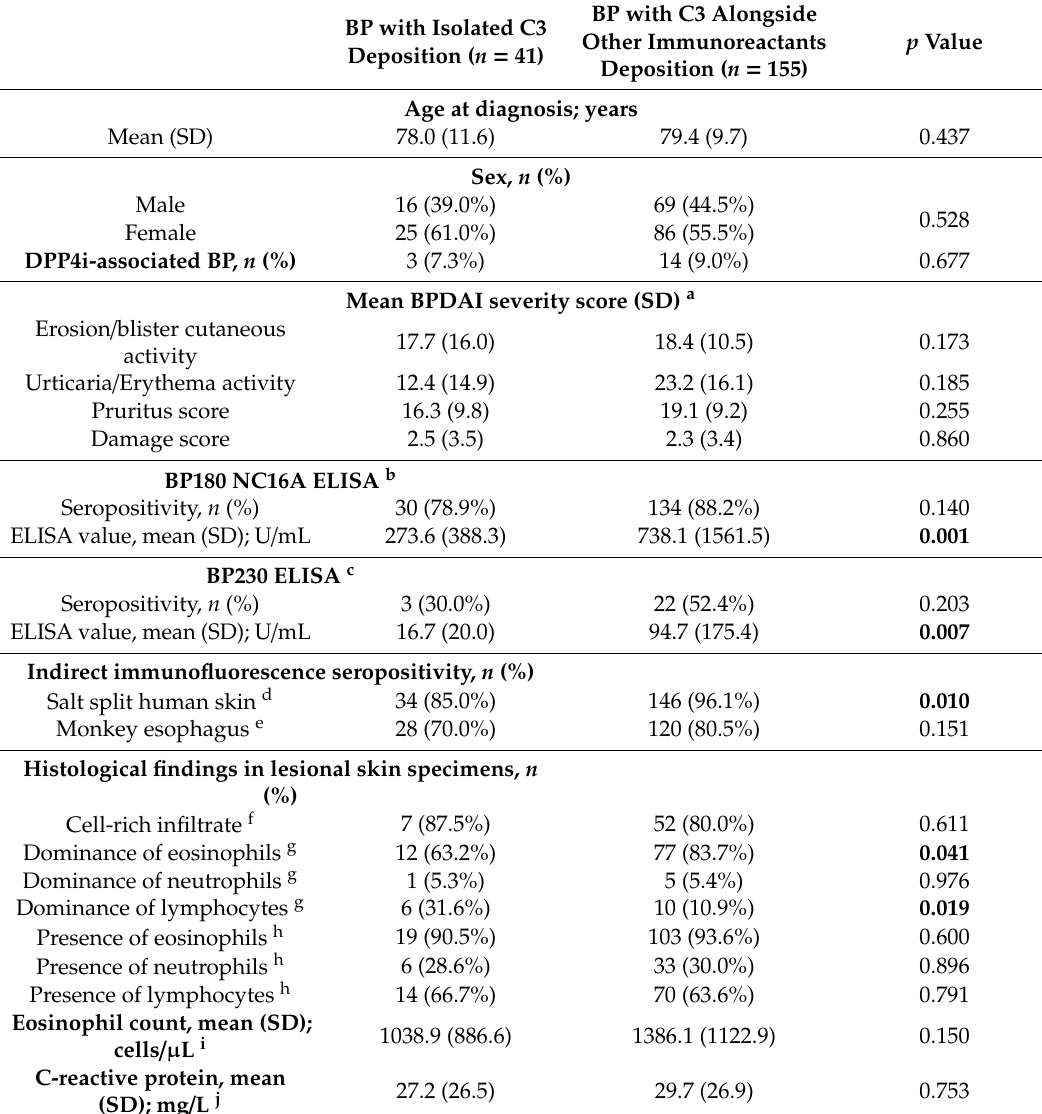
Table 4. Demographic and clinical characteristics of BP patients with isolated C3 deposition by DIF as compared to BP patients with C3 deposition in conjunction with labeling of IgG and / or